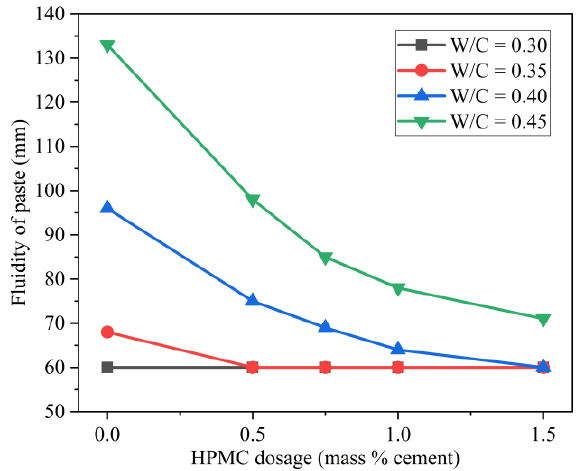
Figure 6. Influence of HPMC dosage and W/C ratio on fluidity of fresh SAC paste.